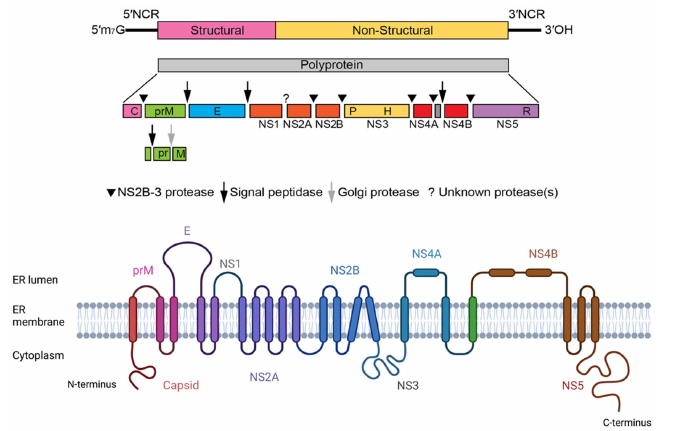
Figure 2. Flavivirus genome structure and chain topology of the translated single polyprotein of ZIKV.